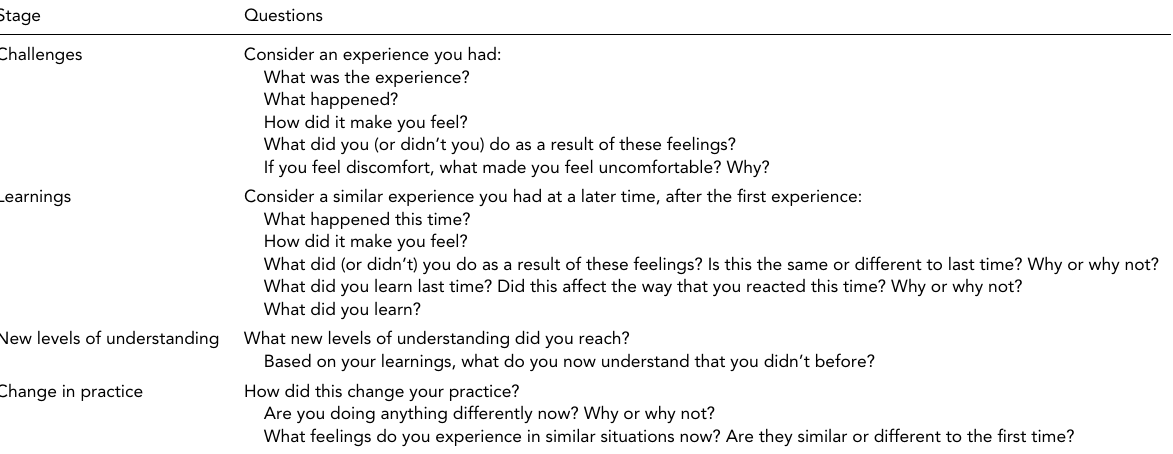
Suggested Questions to Assist Health Professionals, Researchers and Others to be Reflexive in Their Practice in Aboriginal and Torres Strait Islander Health When Experiencing Challenges, Learnings, New Levels of Understanding and Changes in